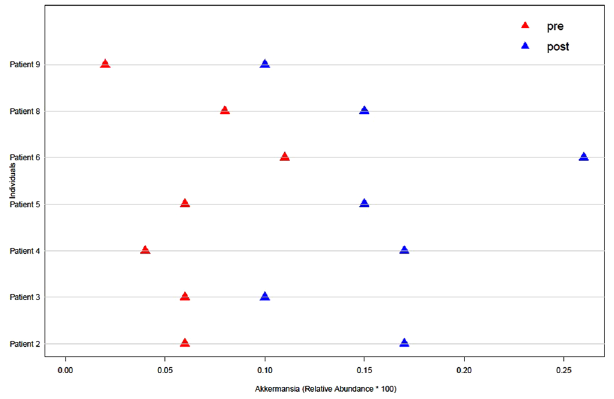
Figure 6. The abundance of Akkermansia in samples from patients collected before and after LT surgery is shown.